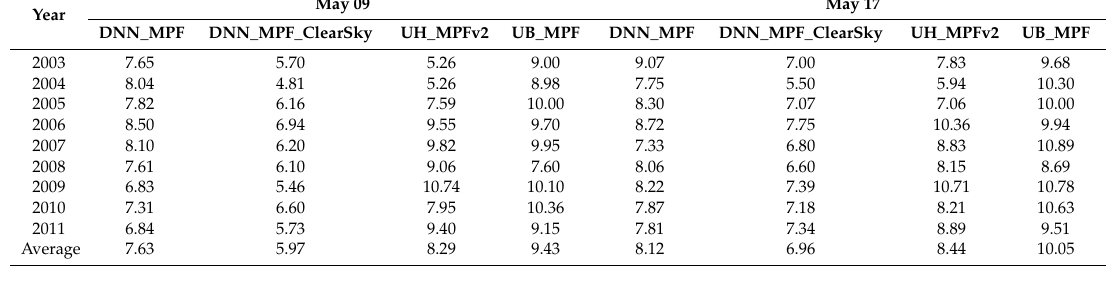
Table 7. Comparison of the retrieved MPFs relative to grid in early to middle May during 2003–2011.